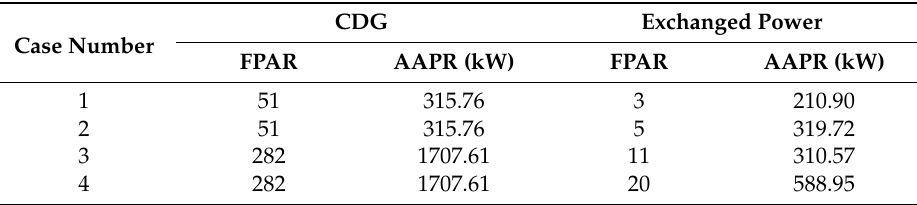
Table 3. Operation simulation results of the generated cases.